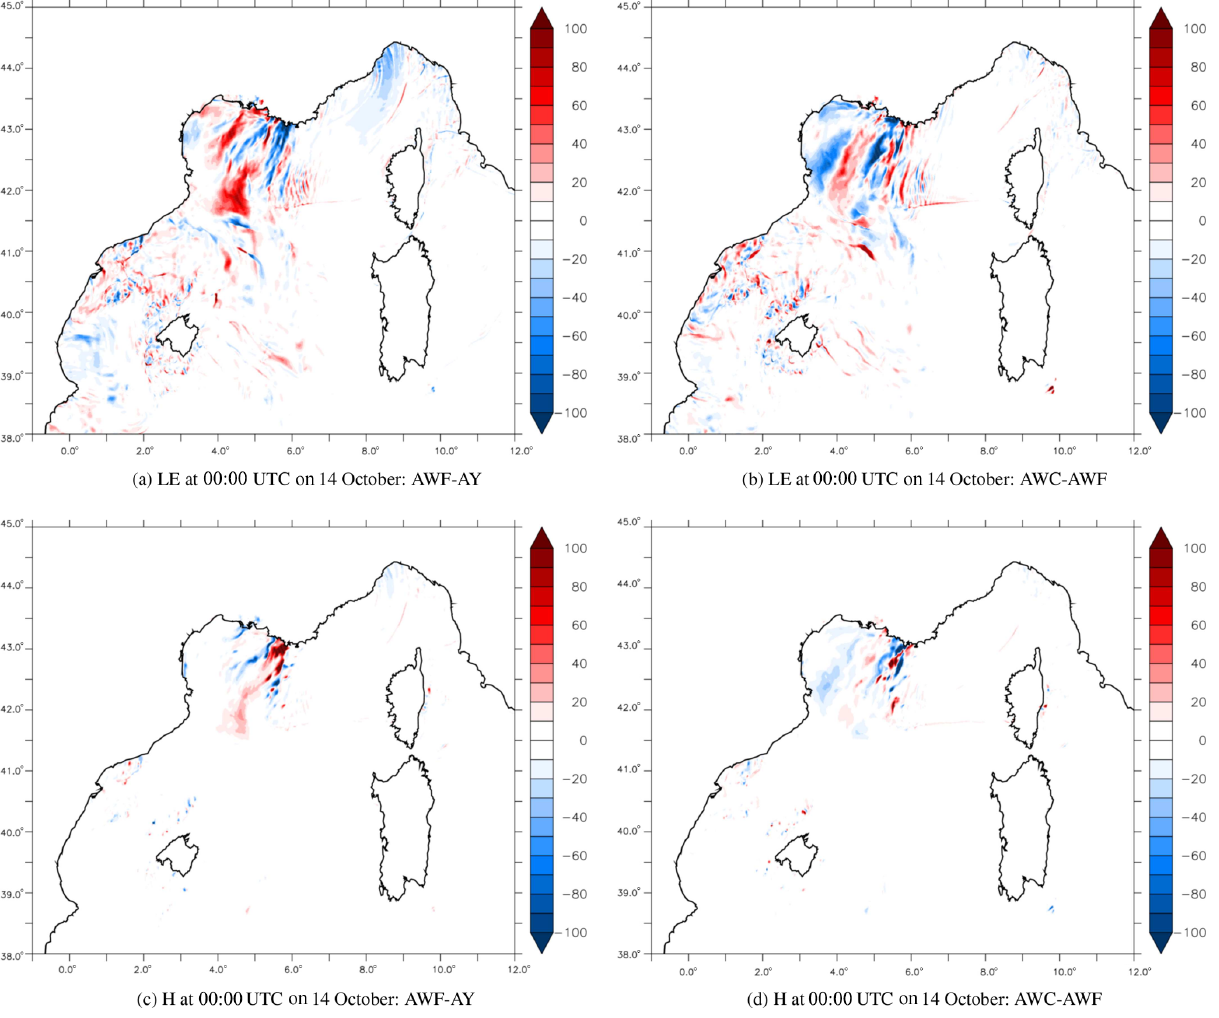
Figure 11. (a, b) LE (Wm − 2 ) and (c, d) H (Wm − 2 ) differences at 00:00UTC on 14 October between AWF–AY (a, c) and AWC–AWF (b, d)